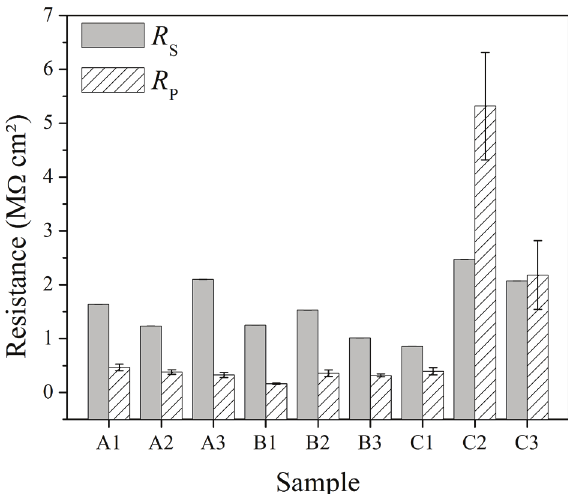
and R for the different S P